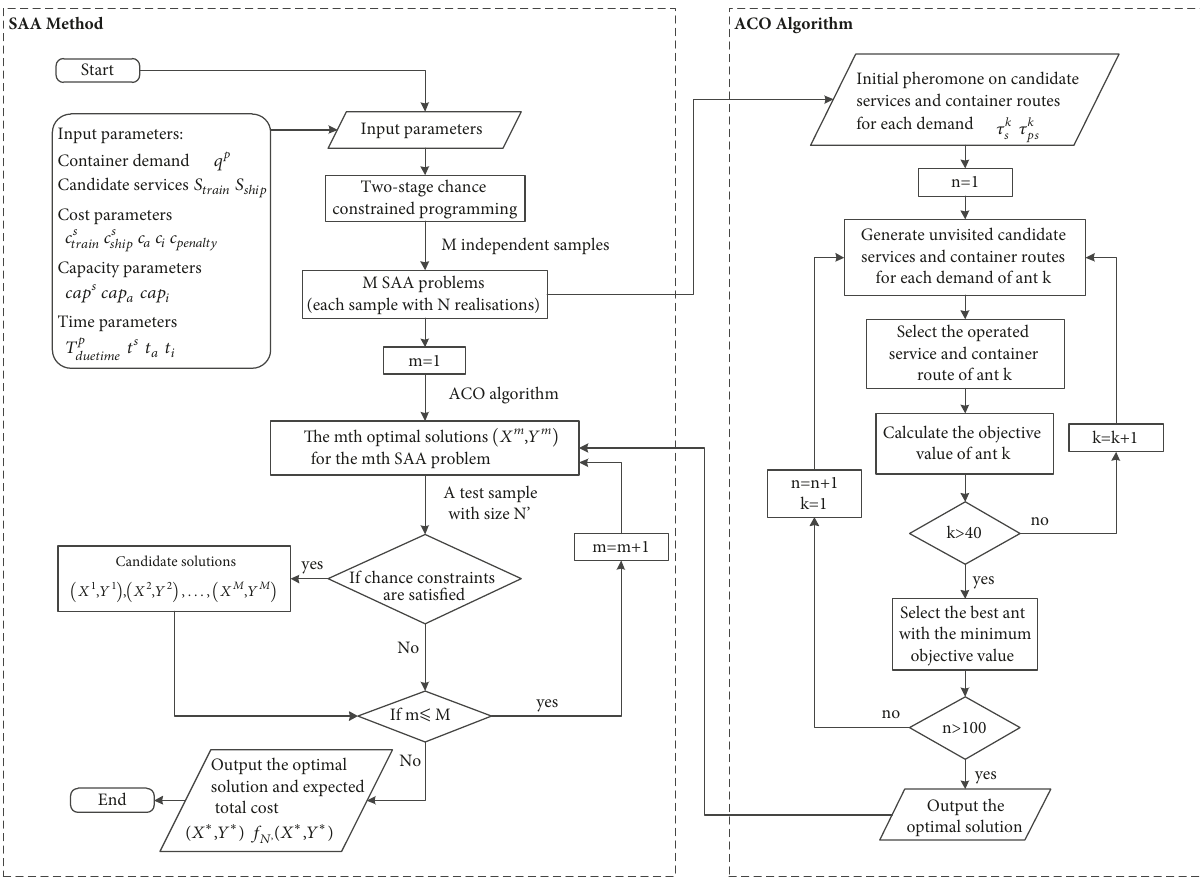
Figure 2: The flowchart of hybrid heuristic algorithm.